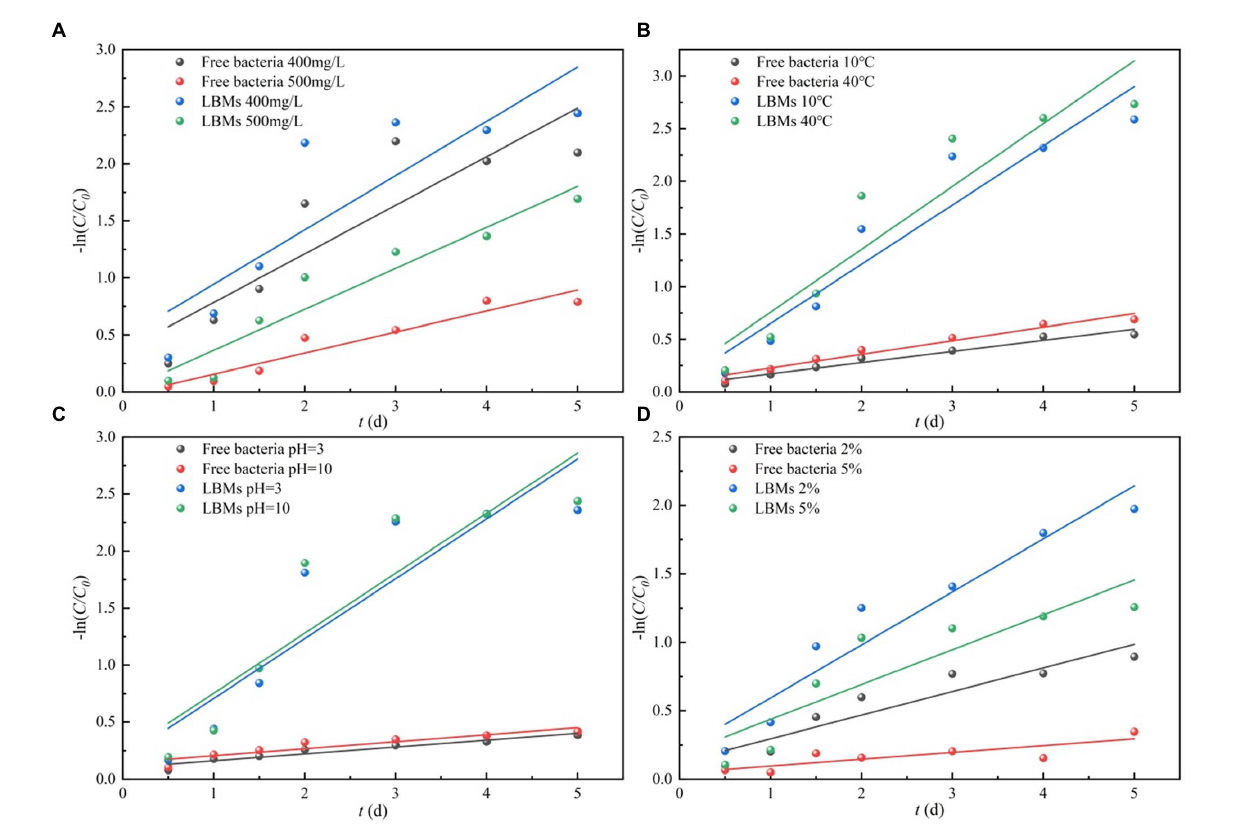
FIGURE 7 First-order kinetic fitting of toluene degradation by free bacteria and LBMs under harsh environmental conditions initial toluene concentrations (A) , temperature (B) , pH (C) and salinity (D) .